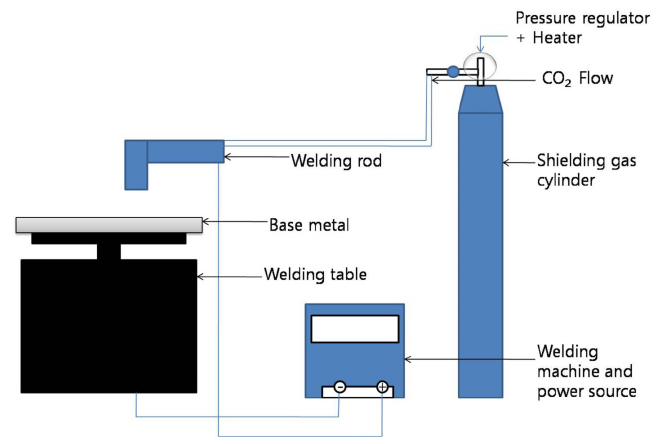
Figure 1. Schematic diagram of welding apparatus setup.